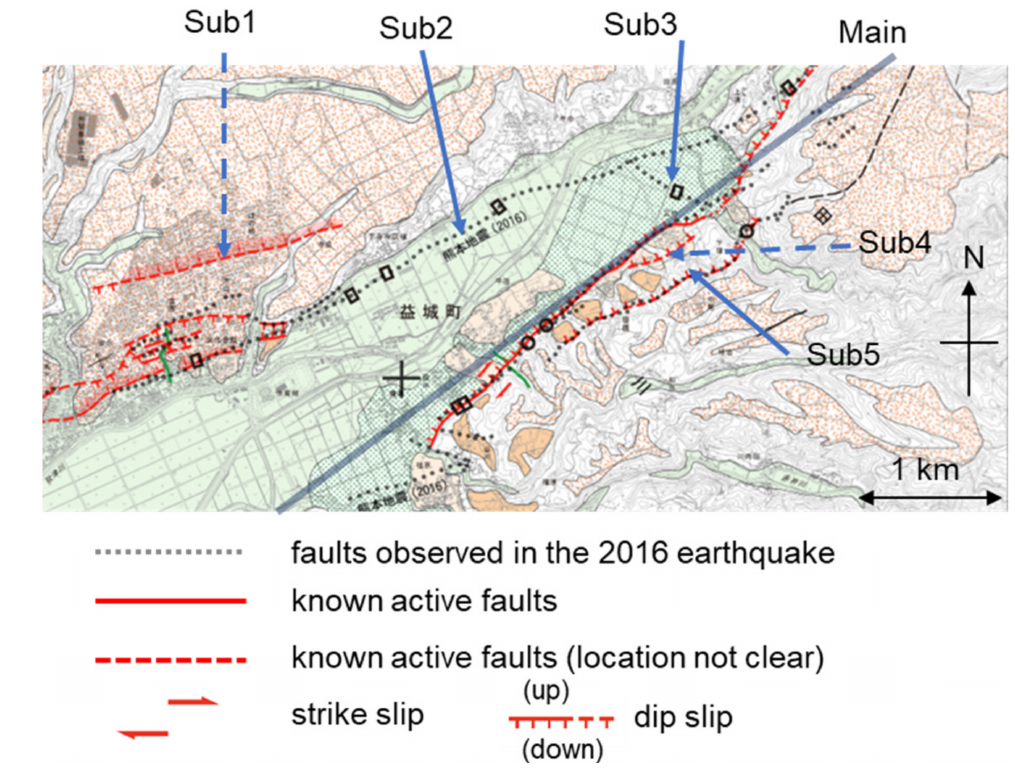
Figure 7. Surface faults along the Kiyama river in Mashiki town. The research area shown in yellow bordered box of Figure